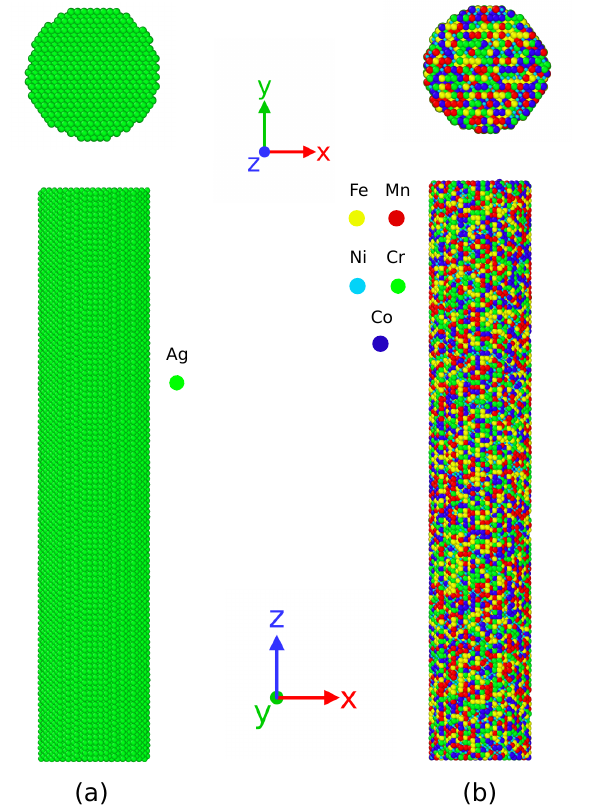
Figure 1. Cylindrical nanowire and corresponding cross-section of ( a ) silver (Ag) nanowire ( b ) CoNi- CrFeMn HEA nanowire. The elements present in HEA nanowire are shown in different